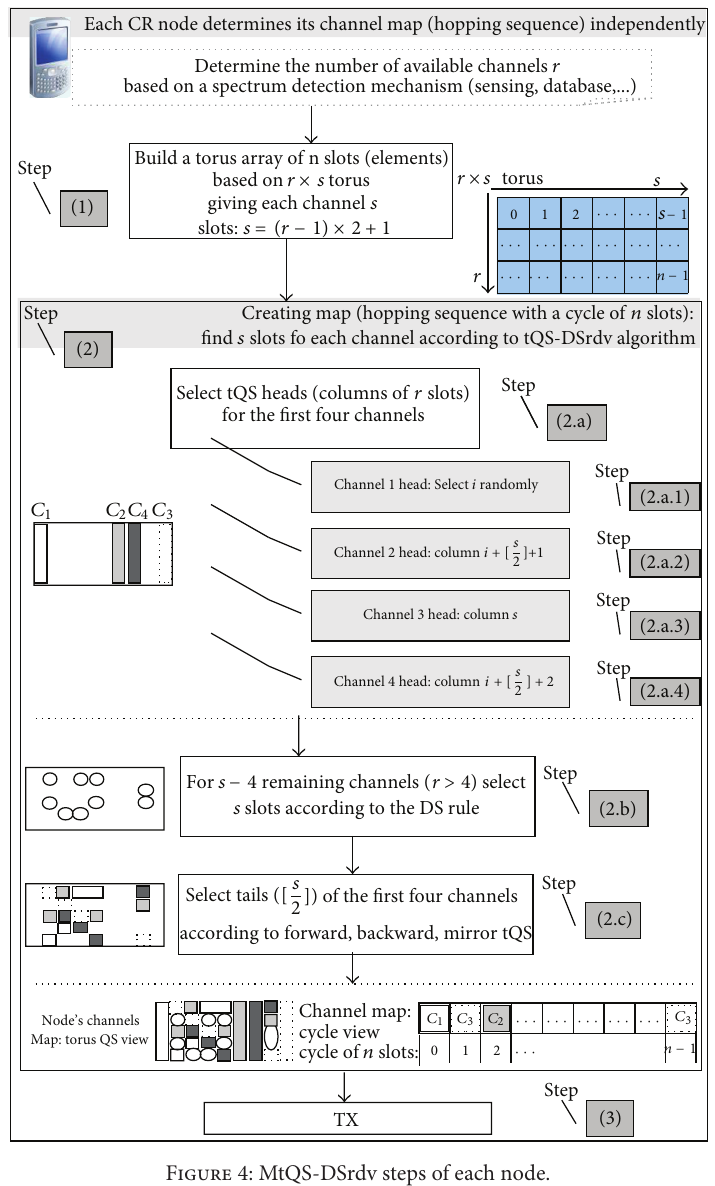
Figure 4: MtQS-DSrdv steps of each